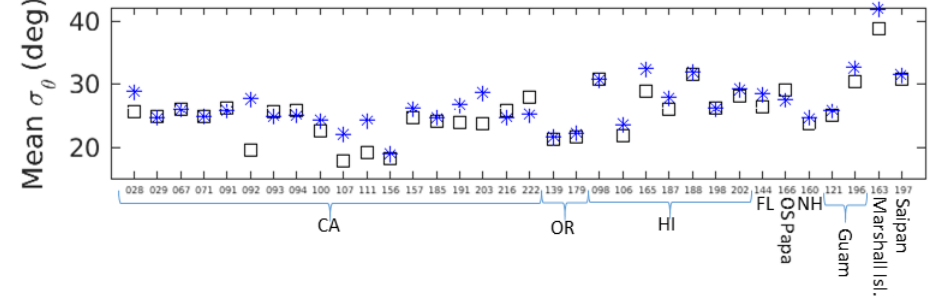
Figure 10. Average directional spread for rogue and non-rogue cases at all analyzed buoy sites. X-